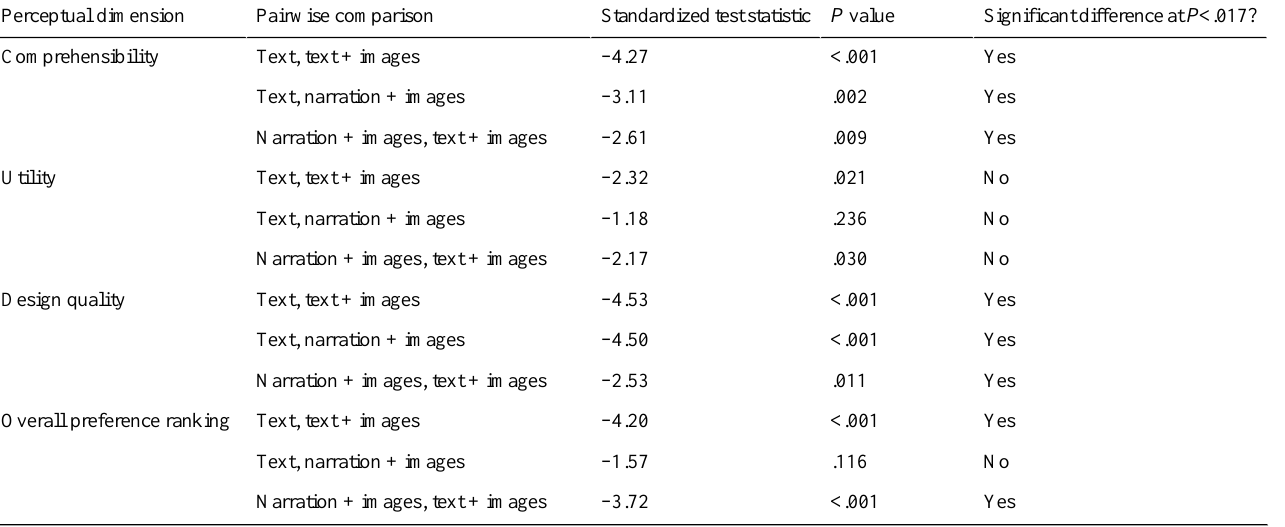
Table 2. Summary of pairwise Wilcoxon signed-rank tests for perception and preference